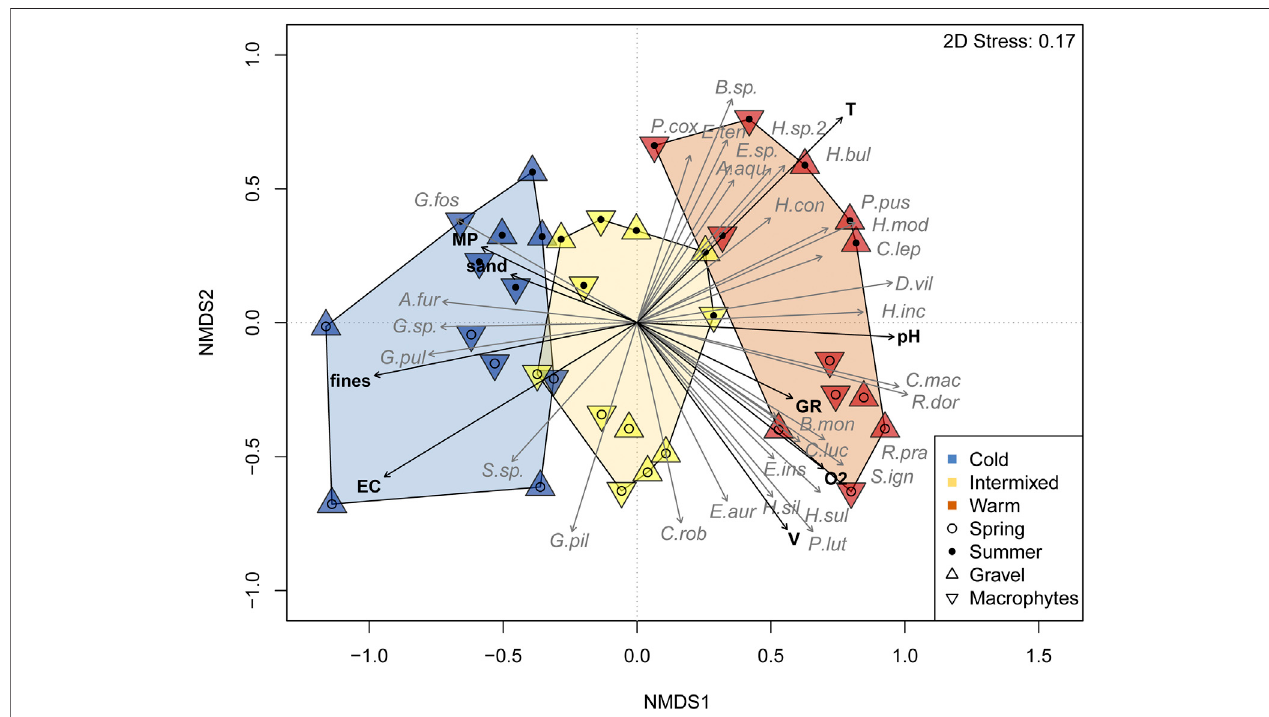
FIGURE 5 | Non-metric multidimensional scaling of spring and summer sampling based on macroinvertebrate abundance data and Bray-Curtis similarity. 2D Stress = non-metric stress value after Kruskal. Thermal regions are displayed by color- fi lled polygons determined by grouping of sampling spots per habitat. Signi fi cant environmental variables (T = Temperature, pH, O2 = Oxygen concentration, V = fl ow velocity, EC= Electric conductivity, MP = Macrophyte habitat, GR = Gravel habitat, fi nes = fi ne sediment < 0.85 mm, Sand 0.85 – 2 mm) and species (macroinvertebrates, abbreviations in Appx.1) are displayed as vectors.